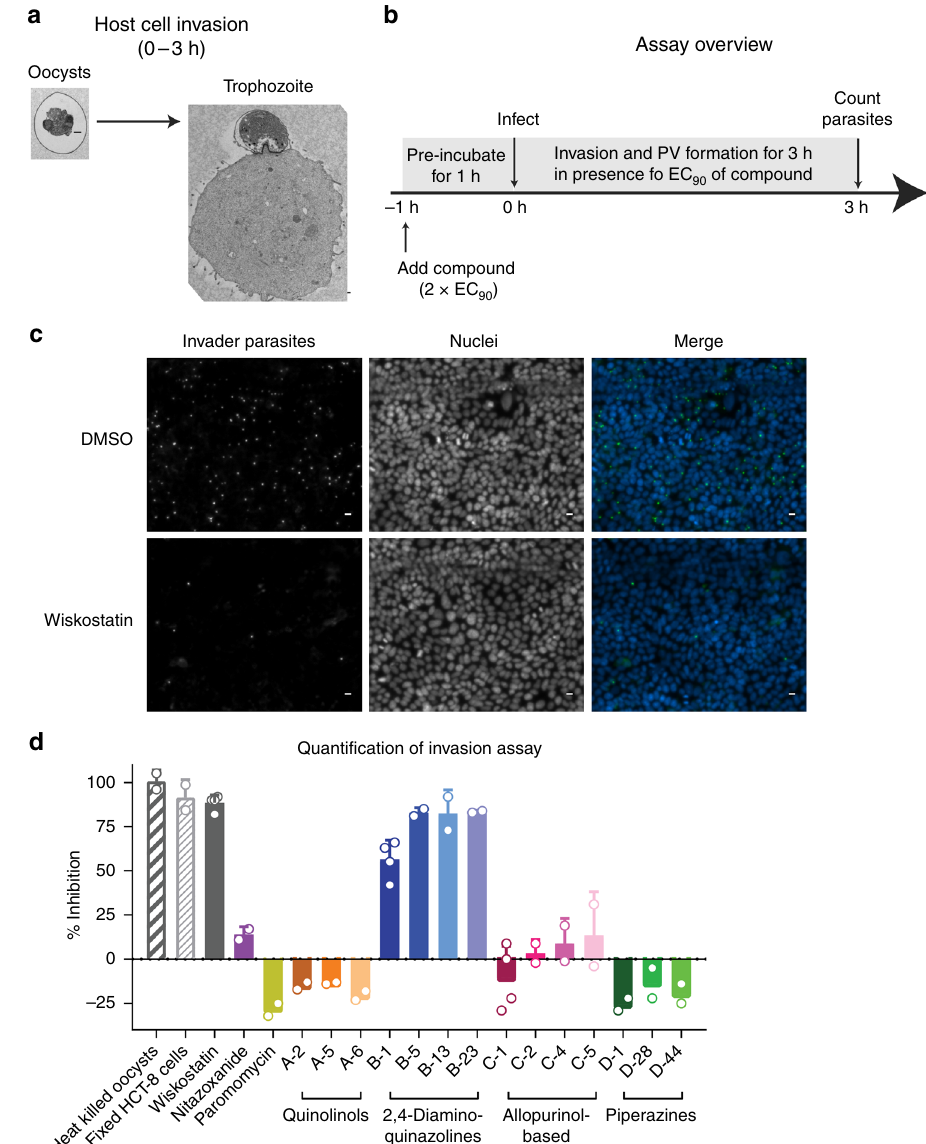
Fig. 2 Invasion Assay. a Overview of life cycle stage investigated during the invasion assay. Representative TEM images of a C. parvum oocyst and HCT-8 cell shortly after infection (Scale bar = 500 nm). b Schematic of experimental design. Con fl uent HCT-8 monolayers were treated with 2 × EC 90 of compounds for 1 h followed by infection with oocysts. Oocysts induced to excyst were incubated on HCT-8 cell monolayers for 3 h in the presence of EC 90 of compounds, after which cells were washed, fi xed, and parasite vacuoles were stained with a fl uorescein- Vicia villosa lectin conjugate. c Representative images of parasite vacuoles (i.e., invaded parasites (green)) and host cell nuclei (blue) after treatment with DMSO control or EC 90 (11.34 µ M) of wiskostatin. Scale = 10 µ m. d Quanti fi ed results for selected controls and compounds. The 2,4-diaminoquinazoline series (parent B-1 (MMV006169)) from the MMV Malaria Box inhibited invasion. Each point represents the mean and SD of at least two biological replicates with four technical replicates per experiment. Source data are provided as a Source Data fi